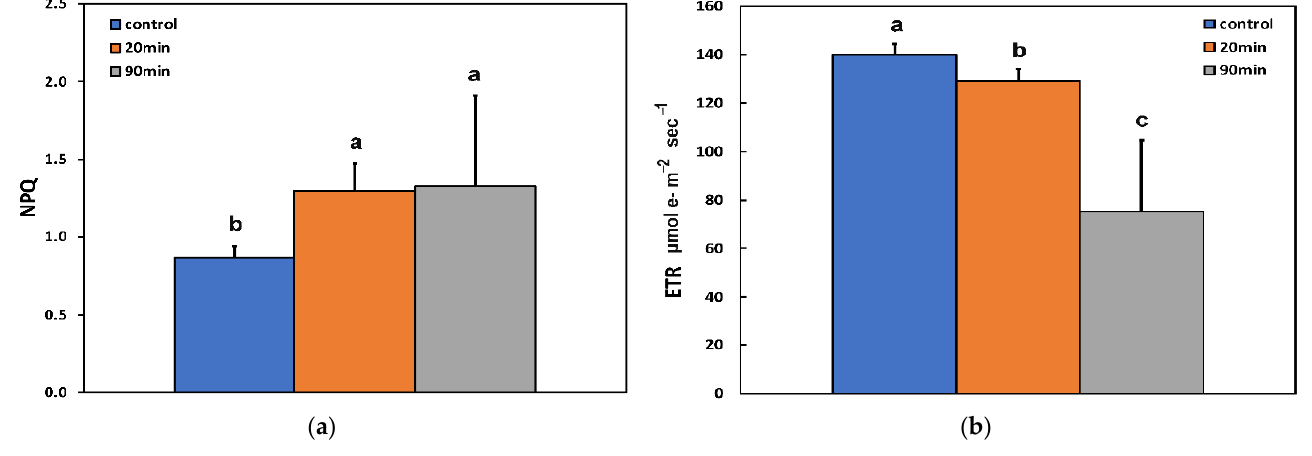
Figure 2. Changes in ( a ) NPQ; and ( b ) ETR (in μ mol electrons m − 2 s − 1 ); of potato leaves, at the whole leaf level, before (control) and after 20 and 90 min feeding by Halyomorpha halys . Error bars ± SD ( n = 5). In each parameter, the columns with different lowercase letters are statistically different ( p < 0.05). The redox state of quinone A (Q A ) at the whole leaf level, representing the fraction of